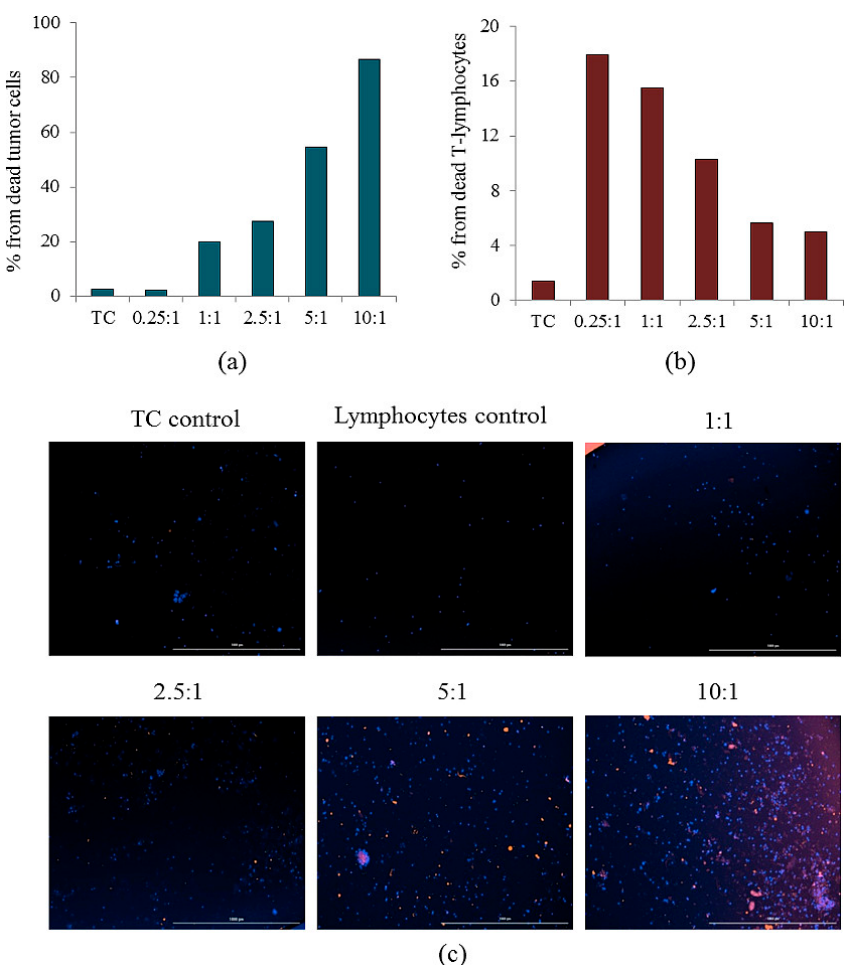
Figure 17. Cytotoxicity and apoptosis of reprogrammed CD8 T-lymphocytes isolated from healthy donor in the primary culture of the adherent mononuclear fraction isolated from the blood of patient G. ( a ) The count of apoptotic tumor cells in the primary culture of the adherent mononuclear fraction isolated from the blood of patient G and ( b ) apoptotic rTcell after cocultivation; ( c ) staining of cell nuclei—Hoechst 34580, T-lymphocytes—CFSE, and dead cells—7-AAD. All scale bars are 1000 µ m. Magnification × 4; 1:1, 2.5:1, 5:1, and 10:1 is the ratio of lymphocytes from a healthy donor and culture fraction of patient G. Table 2. Cytotoxicity of reprogrammed and naive blood CD3 + CD8 + T-lymphocytes of volunteer K in the primary culture of the adherent mononuclear fraction isolated from the blood of patient G (% dead cells in tumor culture) (M ±